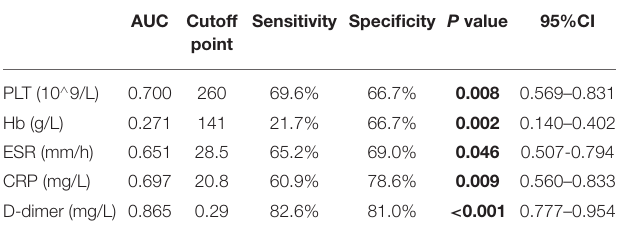
TABLE 3 | Predictive values of the biomarkers for detecting the gut inflammation of patients with SpA. AUC Cutoff Sensitivity Specificity P value point